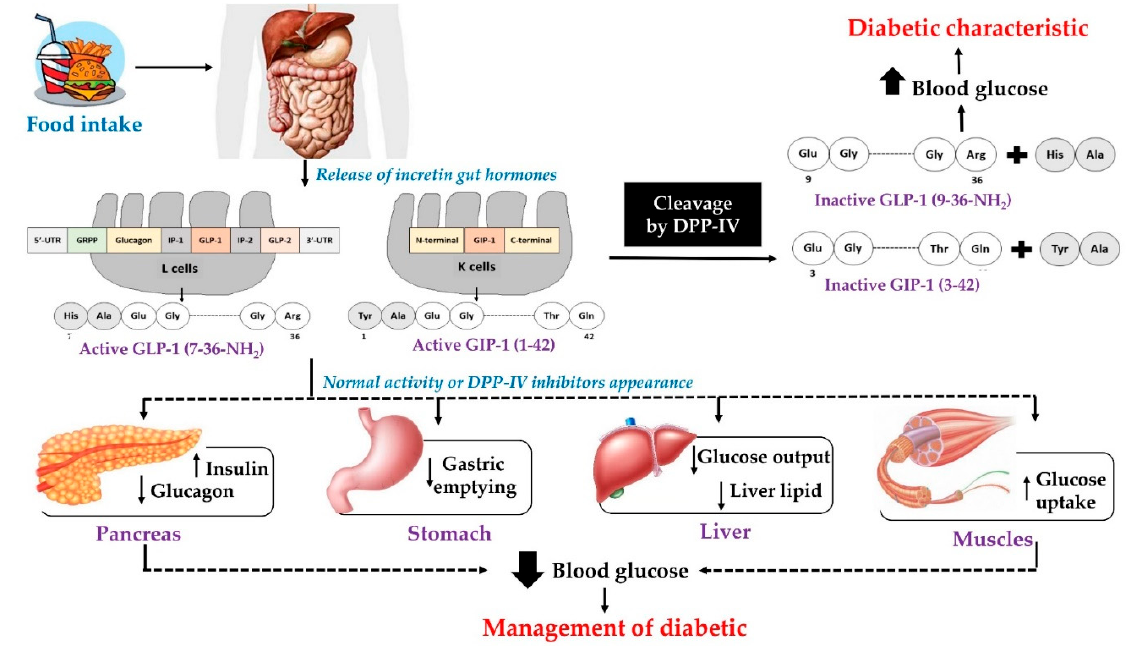
Figure 1. Schematic representation of the mechanism for the glucose-lowering action of DPP-IV inhibitors. GLP-1 and GIP are substrates for the DPP-IV enzyme that hydrolyzes them into shorter and inactive molecules. Note: DPP-IV, dipeptidyl peptidase IV; GIP, glucose-dependent insulinotropic polypeptide; and GLP-1, glucagon-like peptide-1.